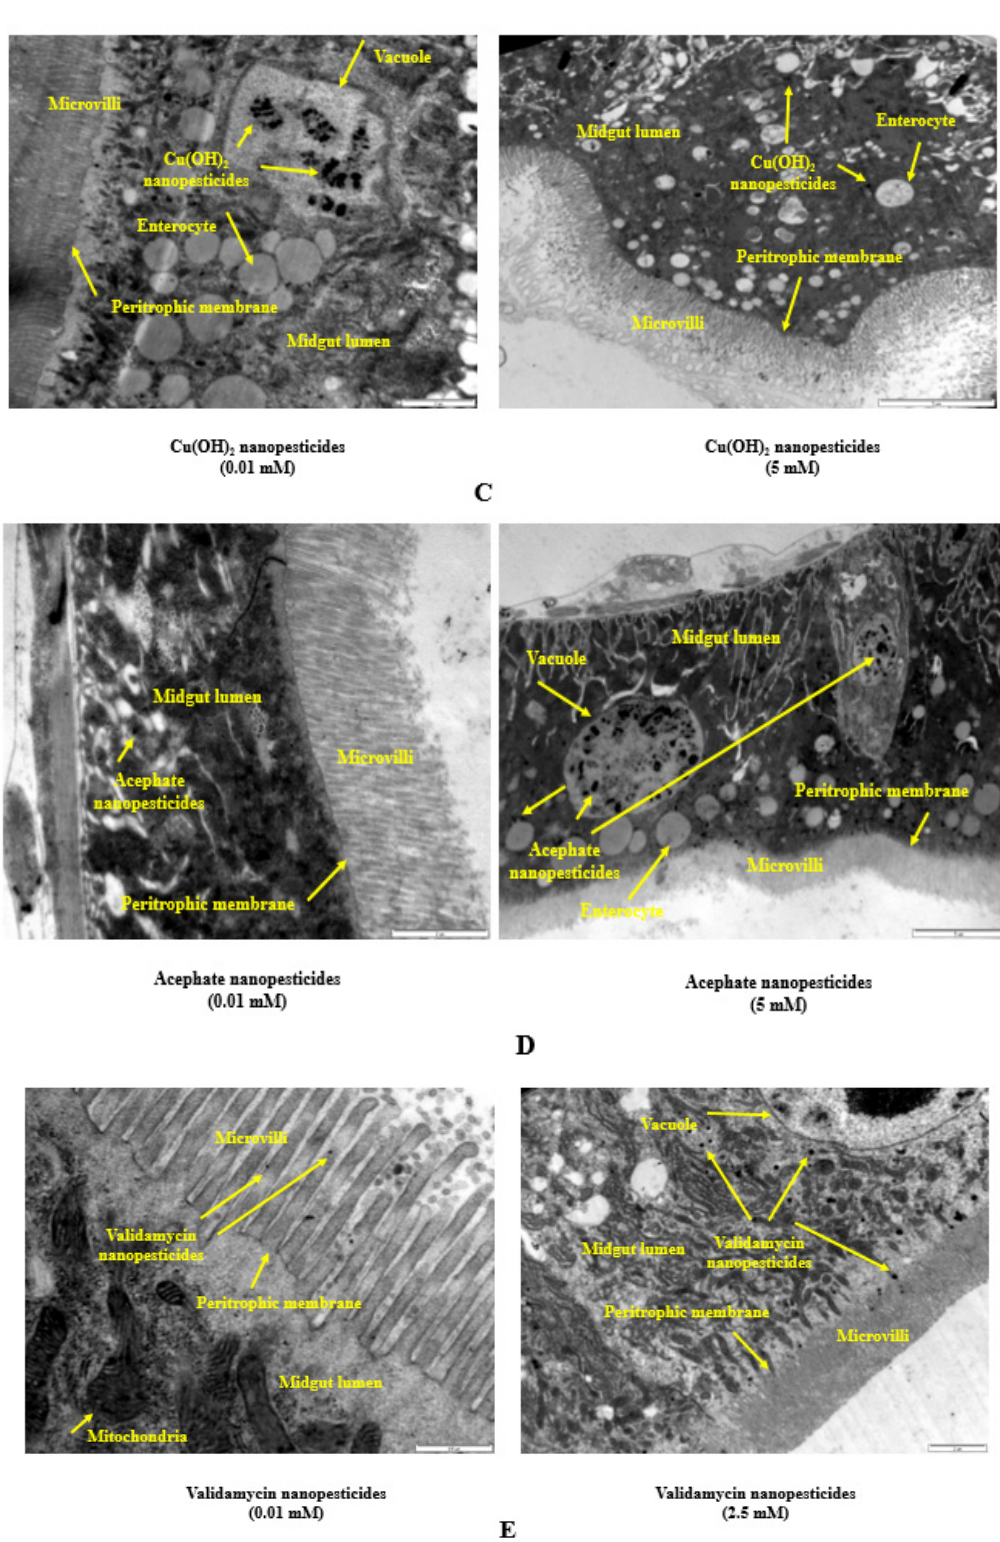
Figure 8. Internalization via the intestinal barrier: Intestinal lumen of Drosophila larvae ( A ). Permethrin nanopesticides ( B ), Cu(OH) 2 nanopesticides ( C ), acephate nanopesticides ( D ), and validamycin nanopesticides ( E ) in the intestinal lumina of Drosophila larvae after oral ingestion. Permethrin nanopesticides perforated the first line of defense of the intestinal barrier—the peritrophic membrane—during their entry into the midgut cells.